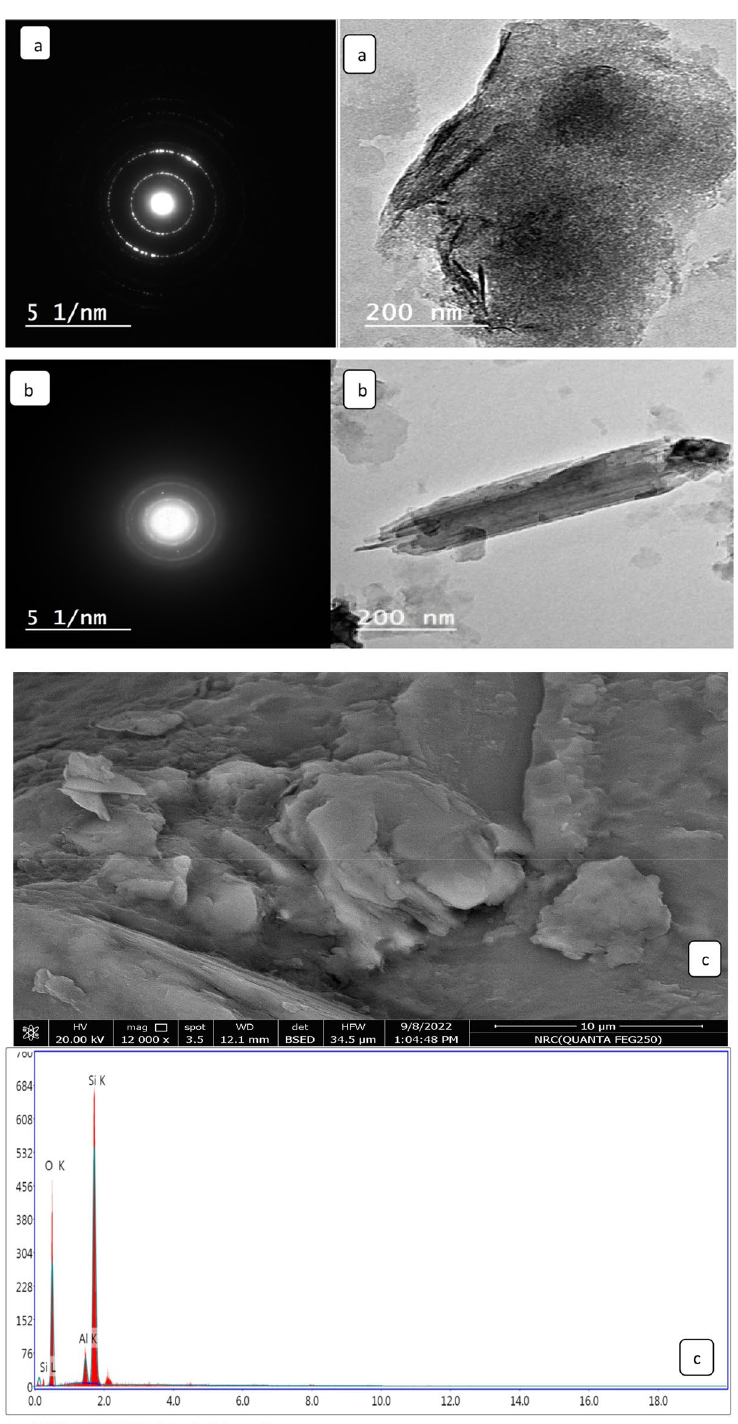
Figure 5. TEM ( a ) nano bentonite, ( b ) MgO impregnated clay, and SEM images and Energy dispersive X-ray analysis ( c ) nano bentonite within EDX, ( d ) MgO impregnated clay within EDX ( e ) nano bentonite after adsorption MG, ( f ) MgO impregnated clay after adsorption MG and ( g ) after adsorption MG by fungi low and high magnification